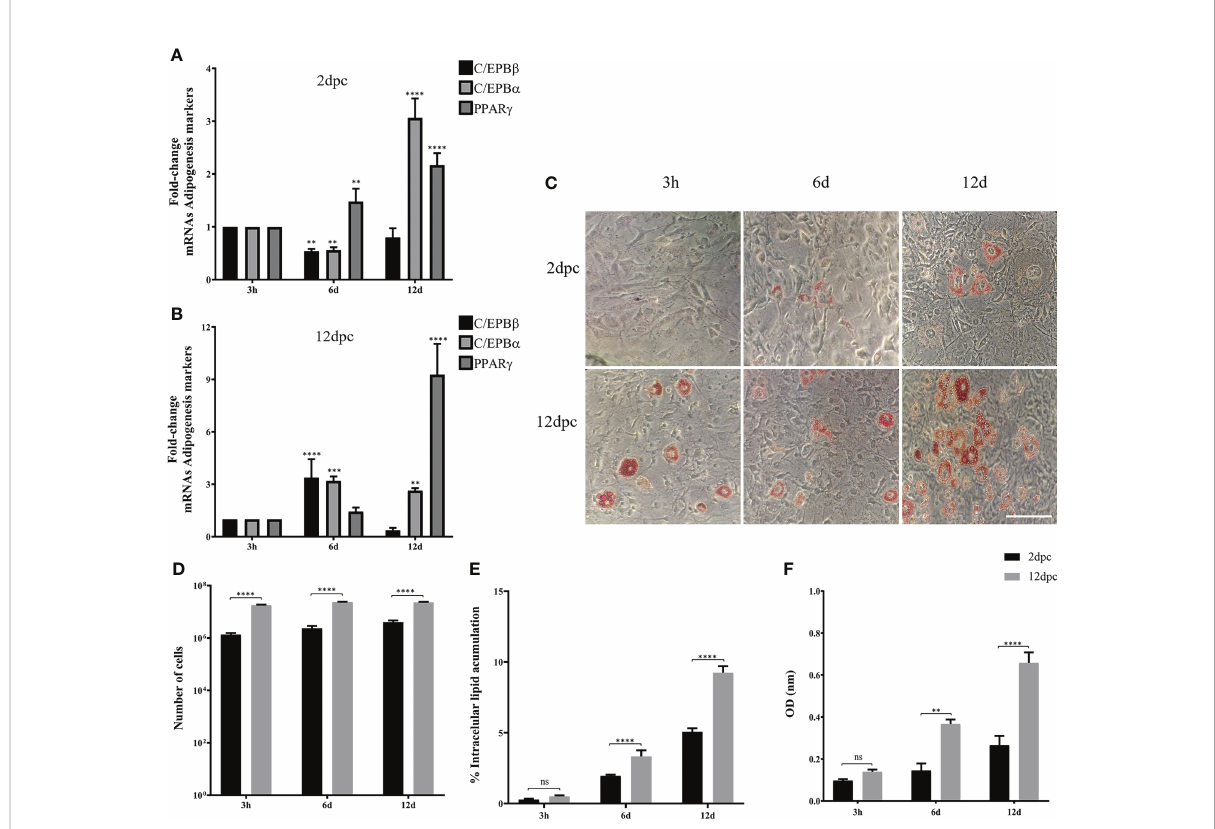
FIGURE 2 3T3-L1 cells at 12 dpc show characteristics of differentiation committed preadipocytes. Differentiation of 3T3-L1 preadipocytes was induced by incubation postcon fl uence and addition of MDI. RNA was isolated from 3T3-L1 cells at 2 dpc (A) or 12 dpc (B) , and expression levels of C/EBP b , C/EBP a , and PPAR g were analyzed by RT-qPCR. Intracellular lipid accumulation was observed by ORO staining and white fi eld microscopy (C) . Scale bar = 100 m m. Cell numbers were measured using a Neubauer chamber (D) . Changes in the percentage of cells with lipid accumulation were counted using ORO staining and white fi eld microscopy (E) , and the relative quantities of lipid accumulation were determined by elution of ORO staining, measured at 510 nm Optical Density (OD) (F) . Primers were designed to hybridize at exon-exon junctions to measure mature mRNA. All values represent the mean of two independent experiments, measured in technical duplicates. Data are expressed as the mean and error bars represent standard deviations. Signi fi cant differences from each time-point relative to 3h (A, B) and between Mock- and HAdV-D36- infected cells at each time-point (D-F) are indicated by **p < 0,005. ***p < 0,0005. ****p < 0,00001. ns, not signi fi